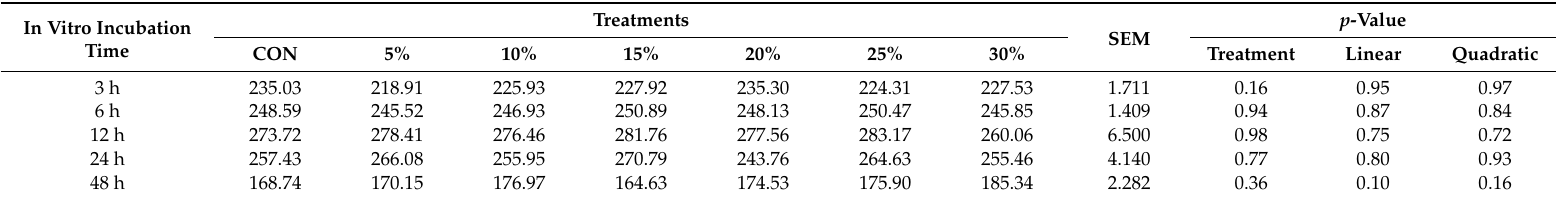
Table 6. E ff ects of di ff erent cassava residue substitution ratio for crushed maize on in vitro MCP content in dairy cows at mid-lactation ( µ g / mL). In Vitro Incubation Time